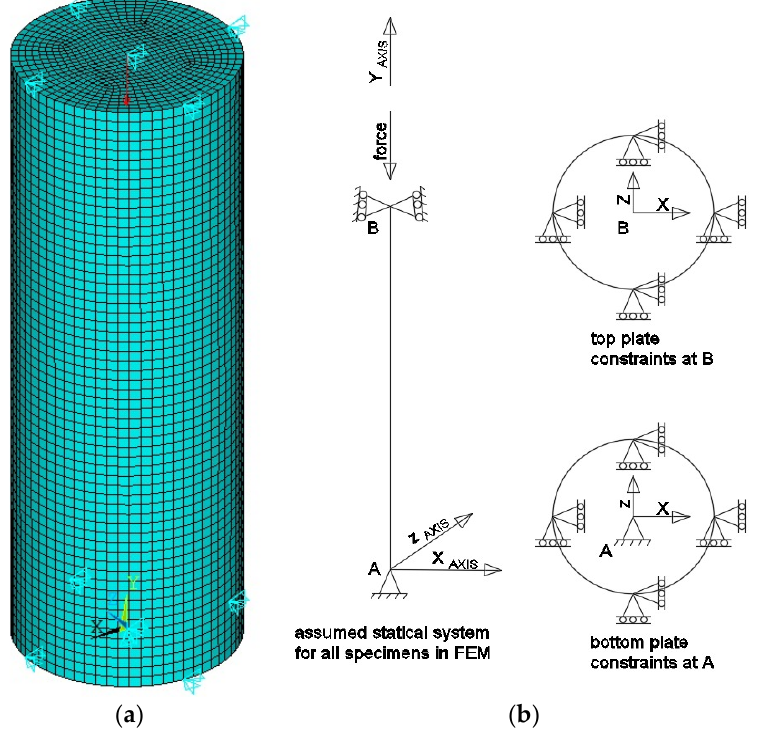
Figure 3. The used finite element model in a numerical study by authors, the assumed boundary conditions and loading condition. ( a ) The used finite element model in a numerical study by authors. ( b ) Assumed boundary conditions and loading condition.